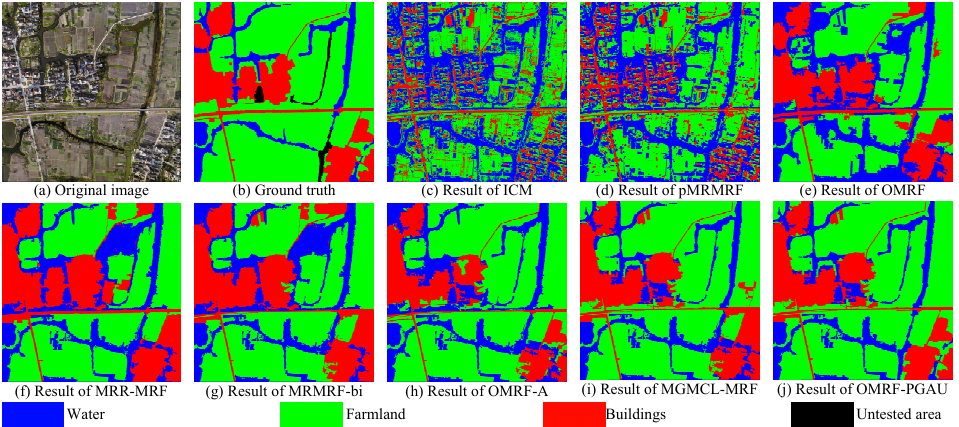
Figure 17. Semantic segmentation results for big size aerial